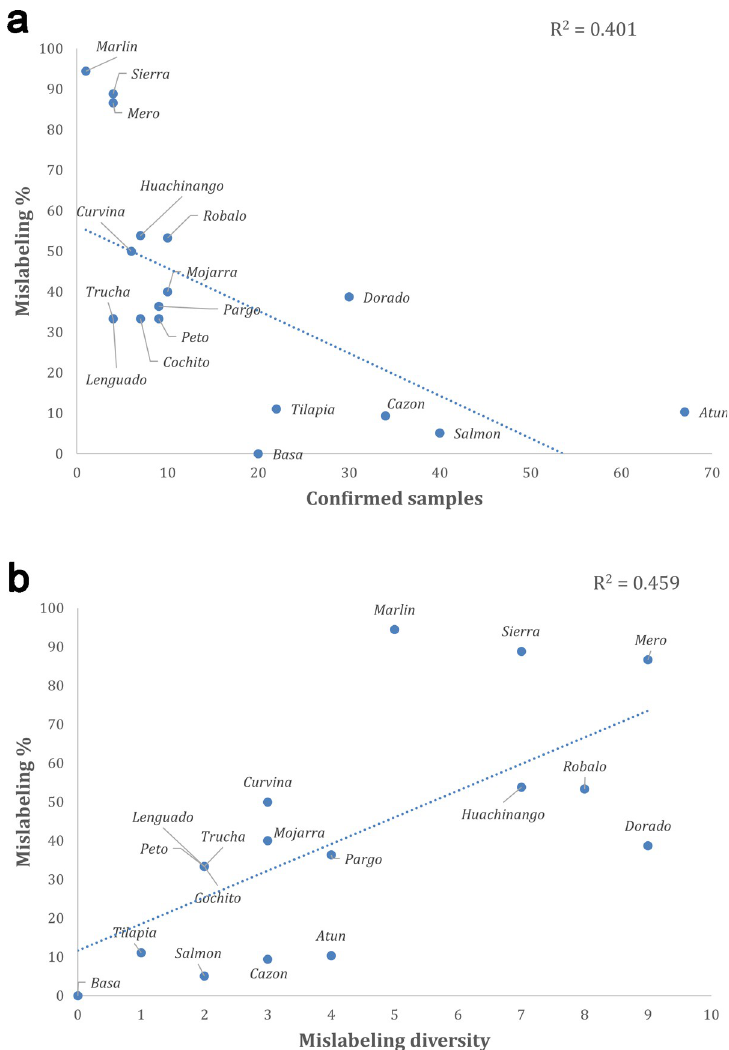
Fig 3. Linear regression analyses showing: A) the relationship of net availability of a species in our dataset (Confirmed number of samples, excluding mislabeling and including samples used to substitute other species) as a predictor of mislabeling rates for the 18 most important commercial names found within three cities of Mexico; B ) the relationship of the number of substitute species sold under the name of the focal species (Mislabeling diversity, a proxy of demand for commercial species in our dataset) as a predictor of mislabeling